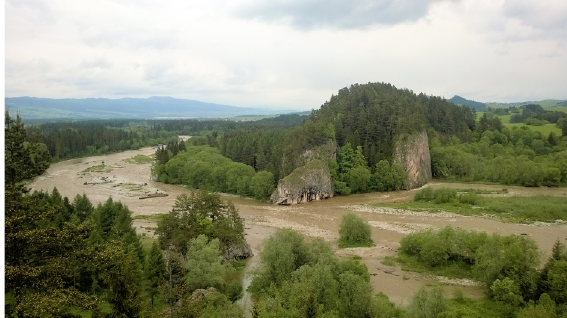
Fig. 3. The Białka Gorge. View from the obłazowa Rock. Photo: A. Chrobak.